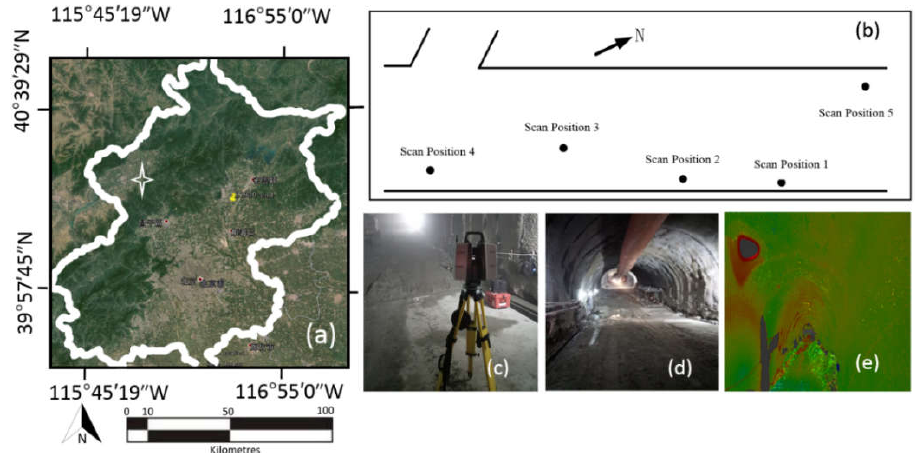
Figure 3. (a) Location of the Badaling Tunnel (left image is from ©Google Earth, Copyright [2013] Google Inc.); the white curve is the boundary of Beijing and the white star is the location of the Badaling Tunnel); (b) locations of the five laser scans inside the tunnel; (c) Leica P40 TLS; (d) tunnel surface (sidewalls close to the ground are too rough and thus excluded in data processing); and (e) example of point clouds collected inside the